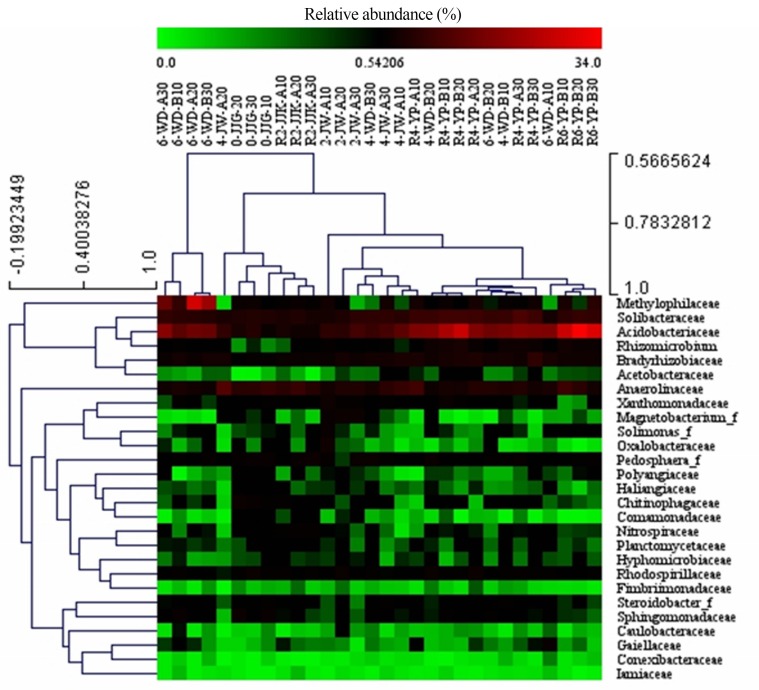
Heat map visualization of the distributions of core assigned families.The assigned families composing the core microbiota of the ginseng soil samples, with up to 46.9% relative abundance.